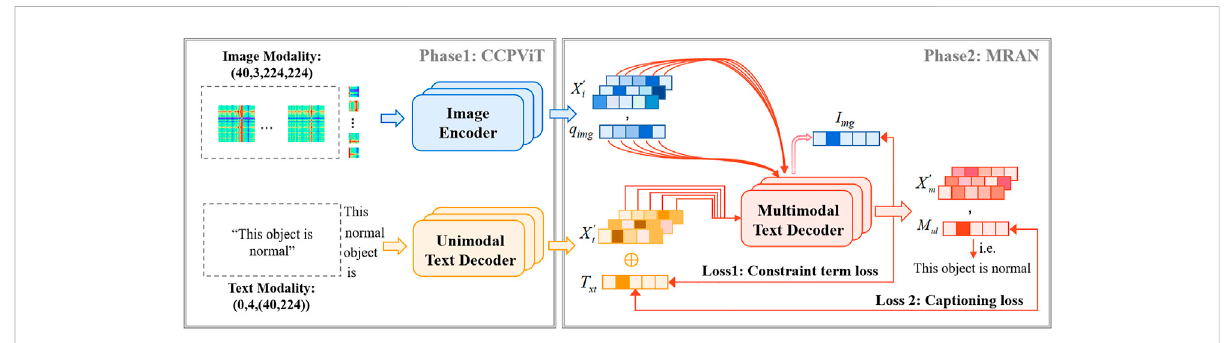
FIGURE 2 Detailed illustration of MMIF during the training period. CCPViT is utilized to learn the unimodal text and image features. MRAN is applied to explore the deep-level interactive representation between cross-modal data. Multimodal fusing embeddings are input to the MMIF model to generate text-only